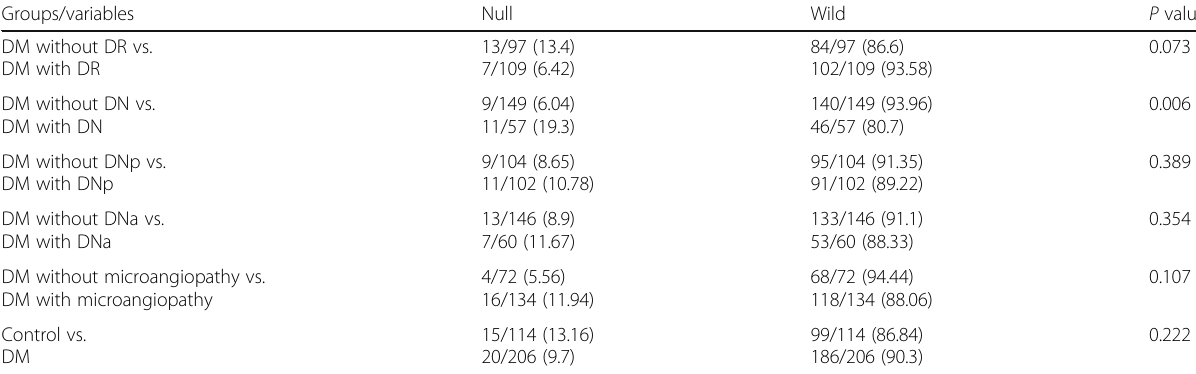
Table 3 The relationship between GSTM1 genotypes and microangiopathic complications in diabetic patients Groups/variables